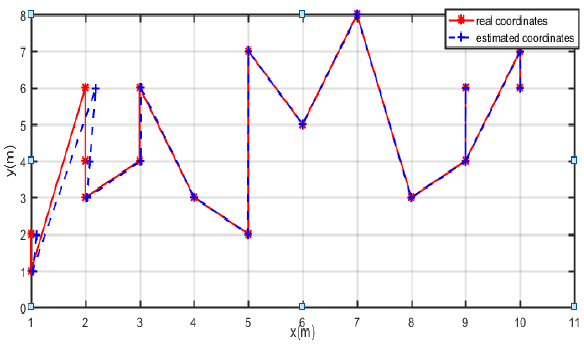
𝑋𝐸2 𝑎𝑛𝑑 𝑌𝐸2 represent also the sum error of the difference between real and estimated coordinates based on random initialization 2. 3. 4. 𝑋𝐸4 𝑎𝑛𝑑 𝑌𝐸4 based on Initialization 4.